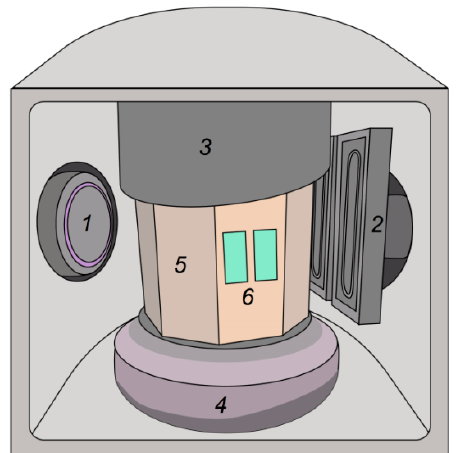
Figure 1. Film deposition facility: 1—anode-layer ion source, 2—dual magnetrons, 3—shield, 4—rotating table, 5—drum with heaters, 6—anode substrates.